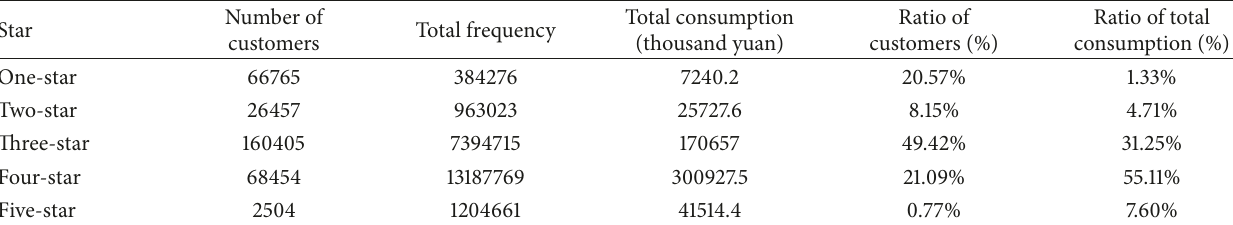
Table 6: Star-rating results for ETC